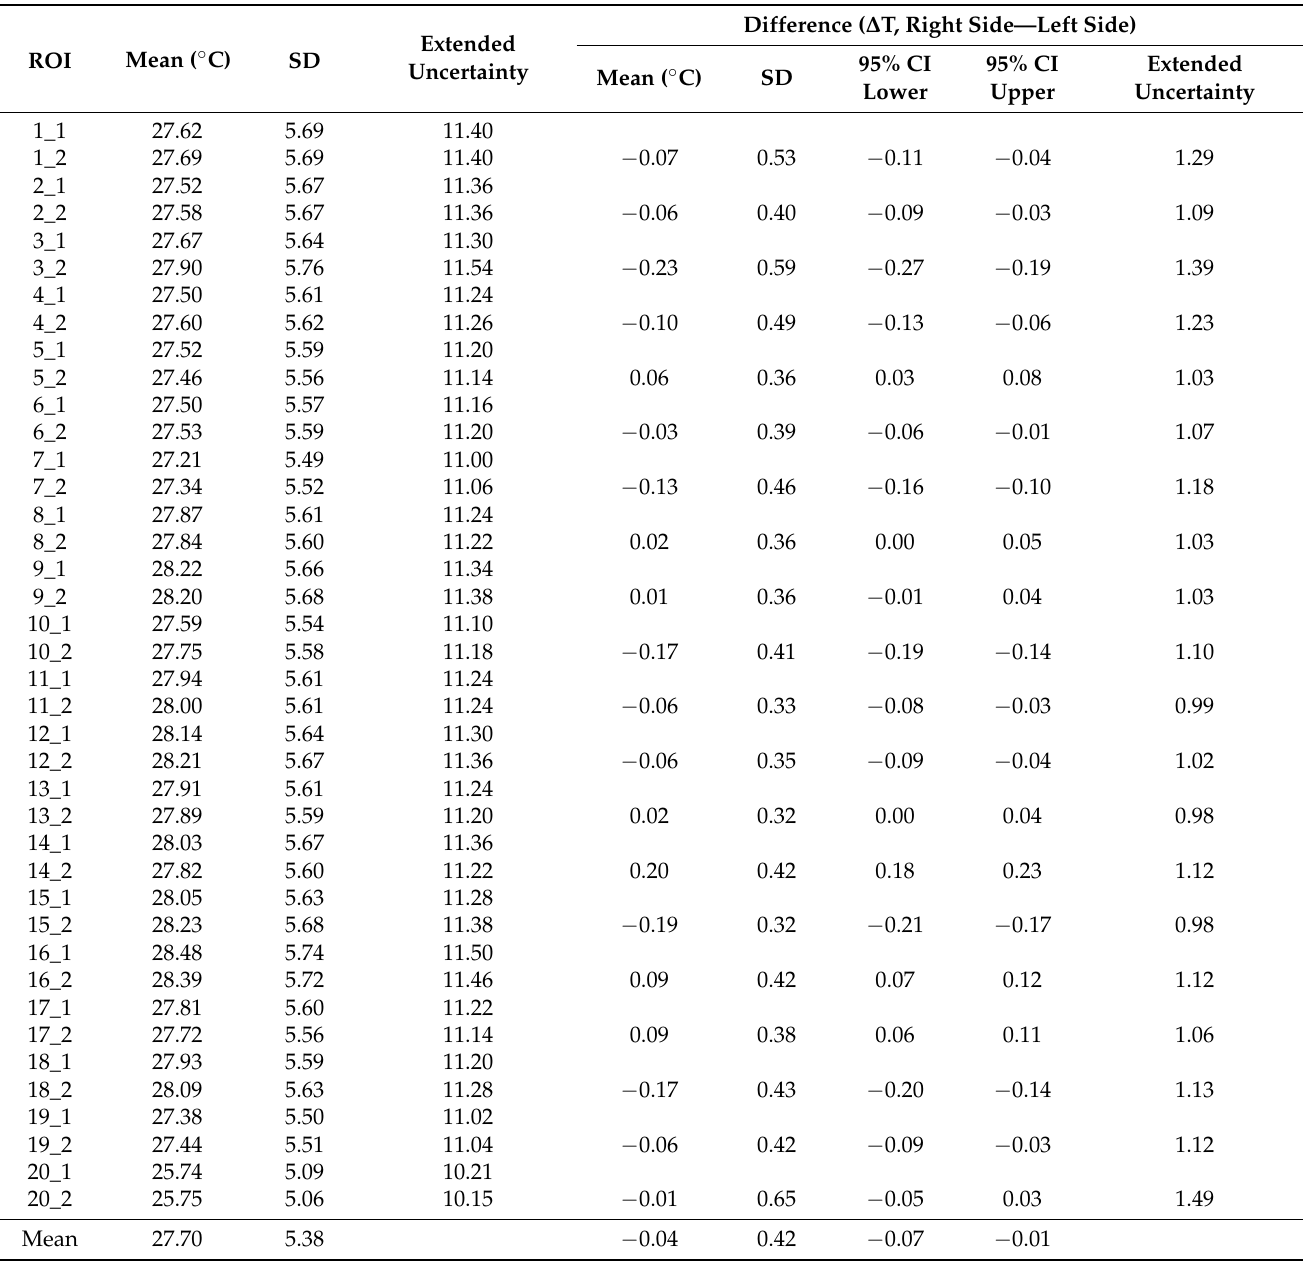
Table 2. Overall mean temperature of regions of interest in the back area.